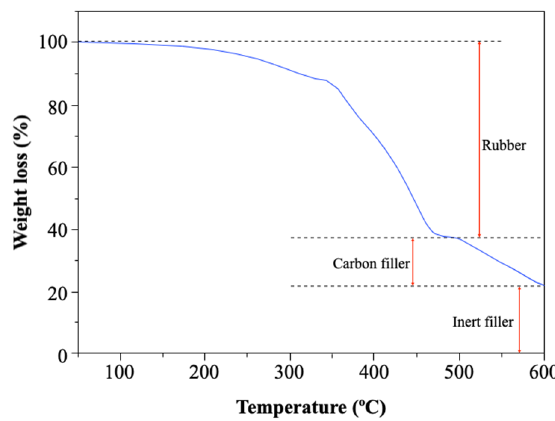
Figure 4. TGA curve made with unheated rubber.